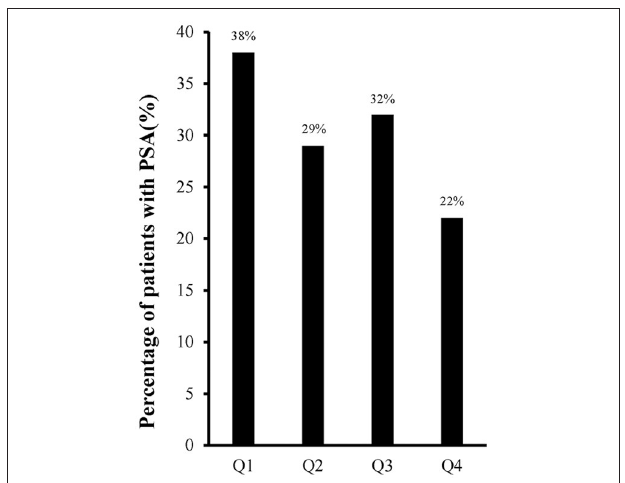
FIGURE 1 | The incidence of PSA each quarter in 2020. Q1, the first quarter; Q2, the second quarter; Q3, the third quarter; Q4, the fourth quarter.